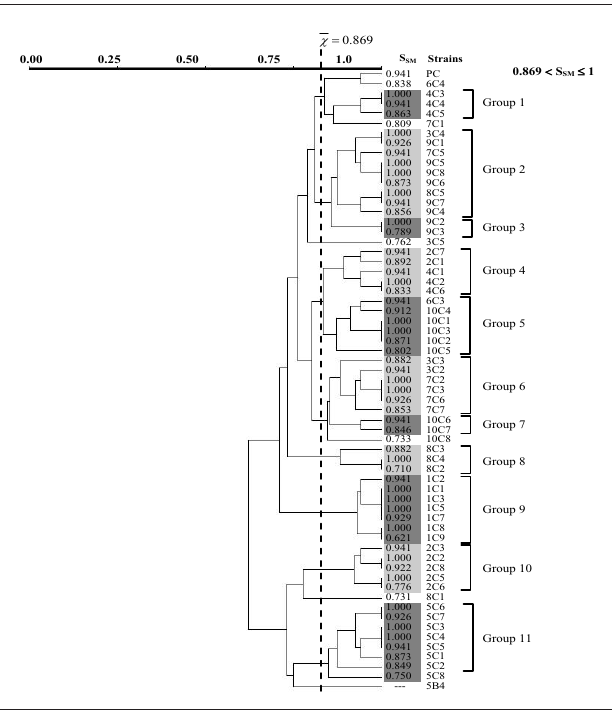
Figure 2. Genetic similarity indices (AP-PCR method, primer OPA-13) verified among S. mutans strains sampled from caries lesions three months after dental treatment – Collect C. Dendrogram generated from UPGMA analysis, using coefficient S (simple matching). Different tonalities of gray in the SM dendrograms illustrate identical or highly related isolates (S ≥ SM